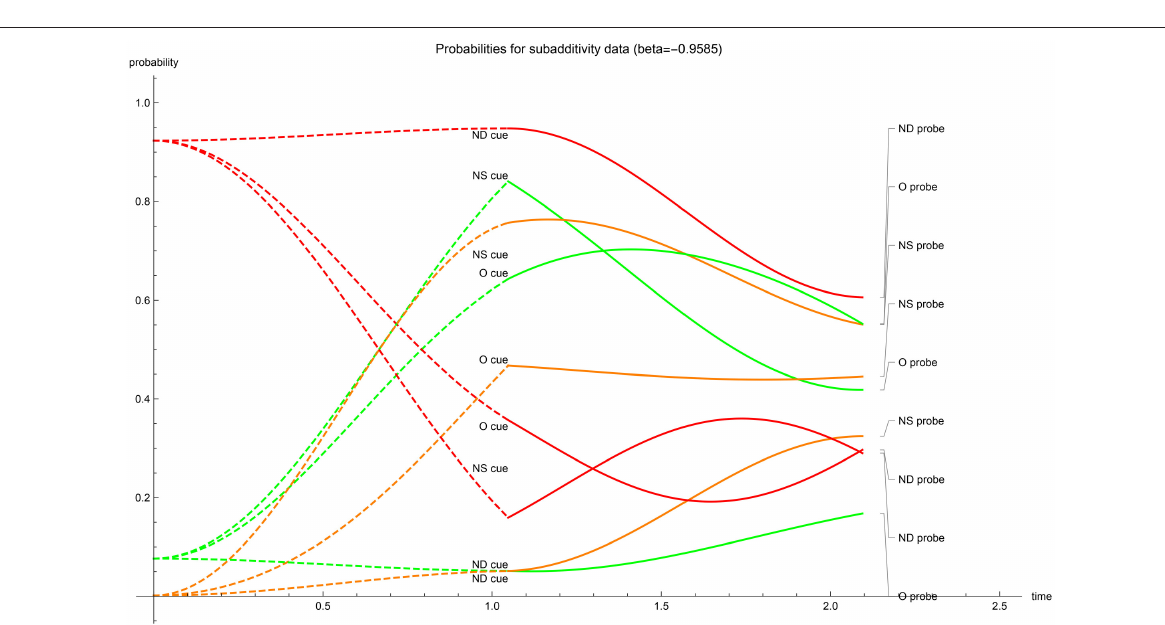
FIGURE 4 | β < 0 case: temporal evolution of acceptance probabilities for the EOD-subadditivity paradigm [1]. Red indicates N probability component, orange indicates G probability component while green indicates V G probability component. Notice the near absence of gist in the initial +